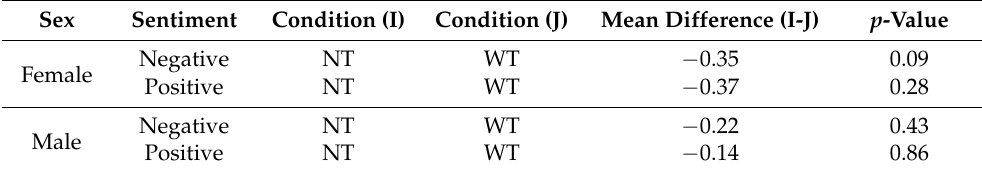
Table 4. Sex Comparison Between Physiological Arousal Change in Utterances (NT vs. WT) by Sentiment